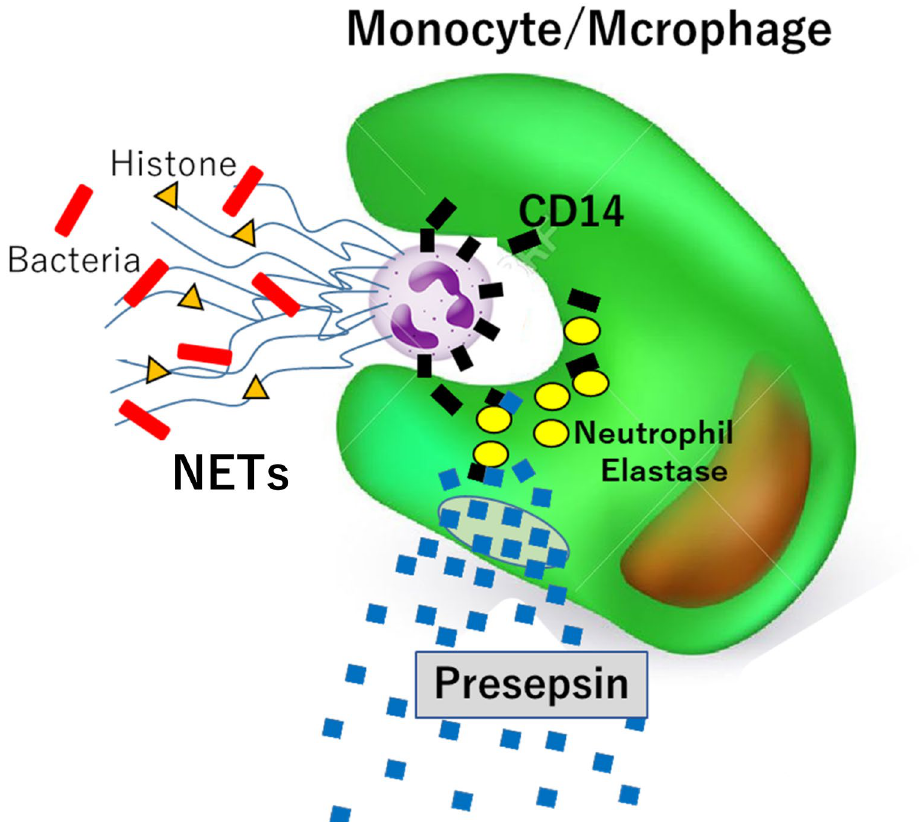
Figure 7. Schematic representation of the mechanism of presepsin production by monocytes/macrophages by NETphagocytosis. Neutrophils invoke NETs in response to infectious bacteria in blood vessels, trapping bacteria and turning them into dead cells. Phagocytosis of NETs by monocytes/macrophages results in intracellular degradation of CD14, which is expressed highly in NETs, and the production of a presepsin, which is released into the extracellular